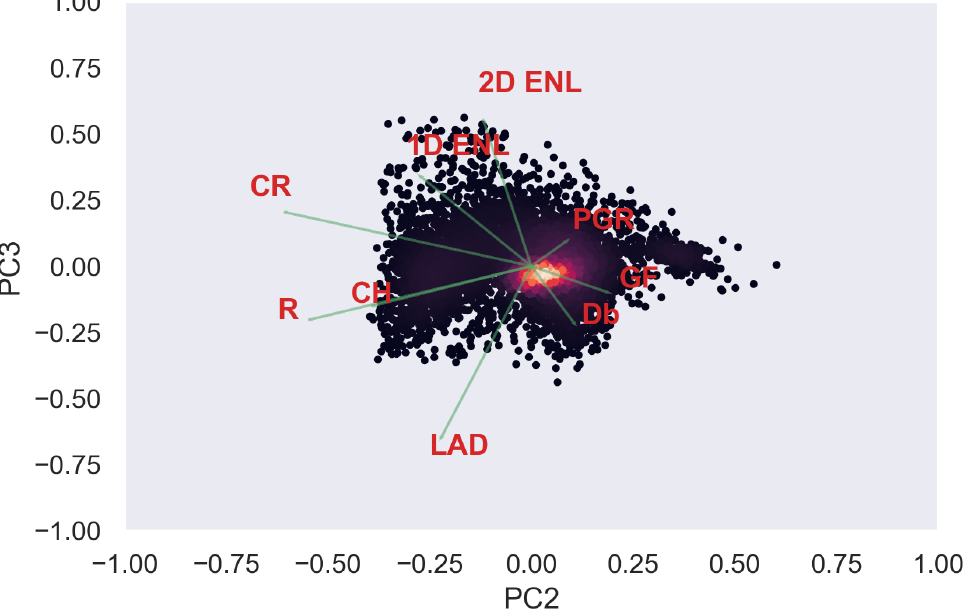
Figure A37. ULS PCA band 2 and 3 loadings at 1m grid size.